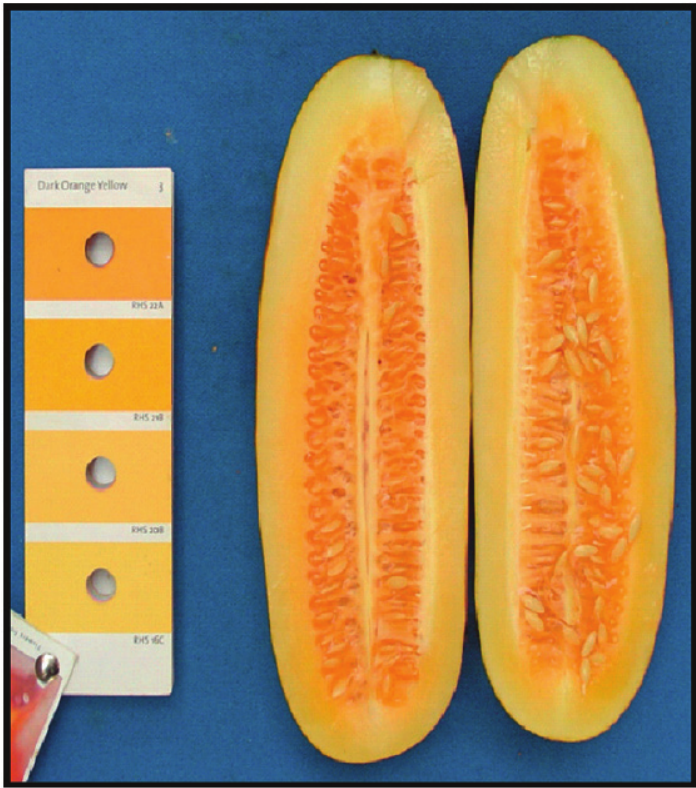
Figure 2. Section of a mature fruit of Cucumis sativus var. xishuangbannanensis . Reproduced from Staub et al.